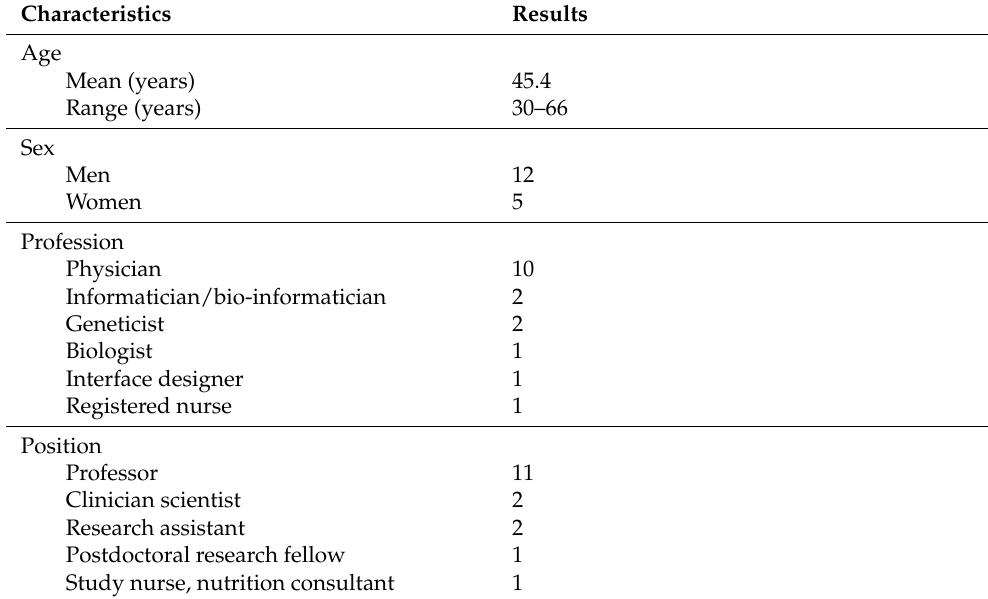
Table 1. Participants’